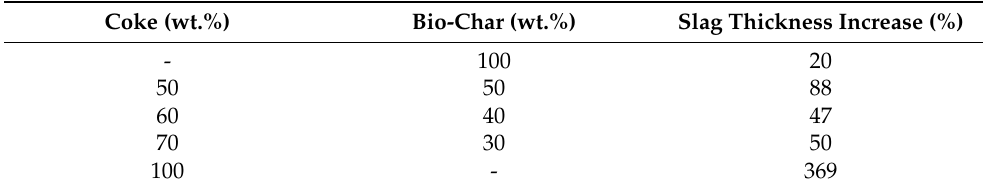
Table 12. Slag layer thickness